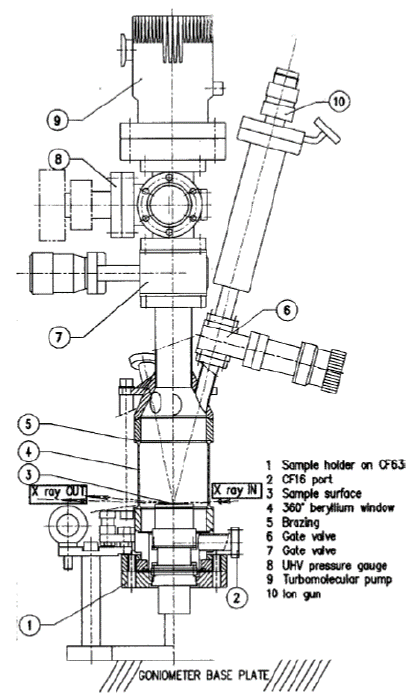
Figure 4. Schematic of the apparatus developed by Bernard et al. [114] for UHV preparation of single crystal surfaces and then Surface X-ray diffraction measurements at elevated pressures (<5 atmospheres) in batch reactor mode. Reproduced with permission from Rev. Sci. Instr. 1999 , 70 , 1478–1480 [114]. Copyright 1999, American Institute of